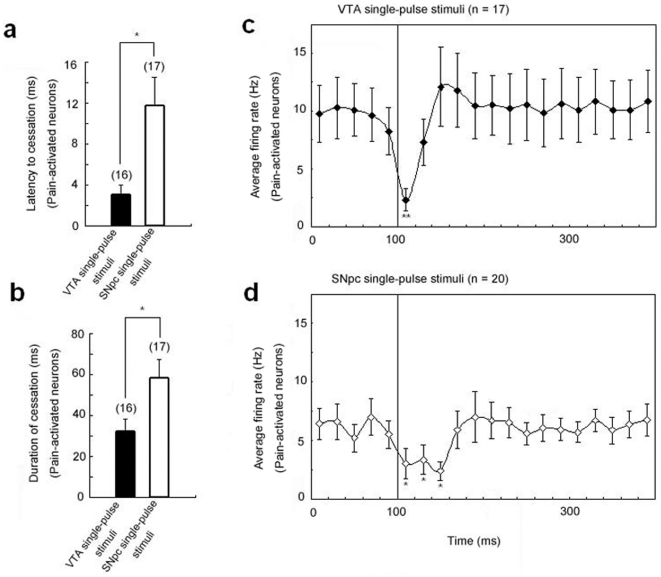
Comparisons between responses of LHb PA neurons to the single-pulse stimuli of respective dopaminergic structures.(a) The latency to onset of the cessation induced by the SNpc stimulus is notably longer than that induced by the VTA stimulus. (b) The duration of cessation in firing of PA neurons in response to the SNpc stimuli seems much more marked than the one in response to the VTA stimuli. Black asterisks indicate a significant difference (P<0.05). (c, d) Average activity of LHb PA neurons during single-pulse stimulation of the VTA (filled rhombus, n = 17) and the SNpc (open rhombus, n = 20), respectively. Single (P<0.005) and double black asterisks (P<0.0001) indicate a marked firing suppression compared with baseline (0 ms to 100 ms). Error bars indicate SEM.